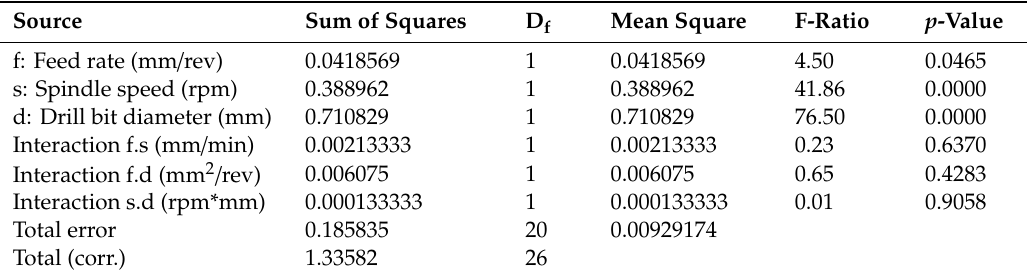
Table 6. ANOVA for surface roughness R a .